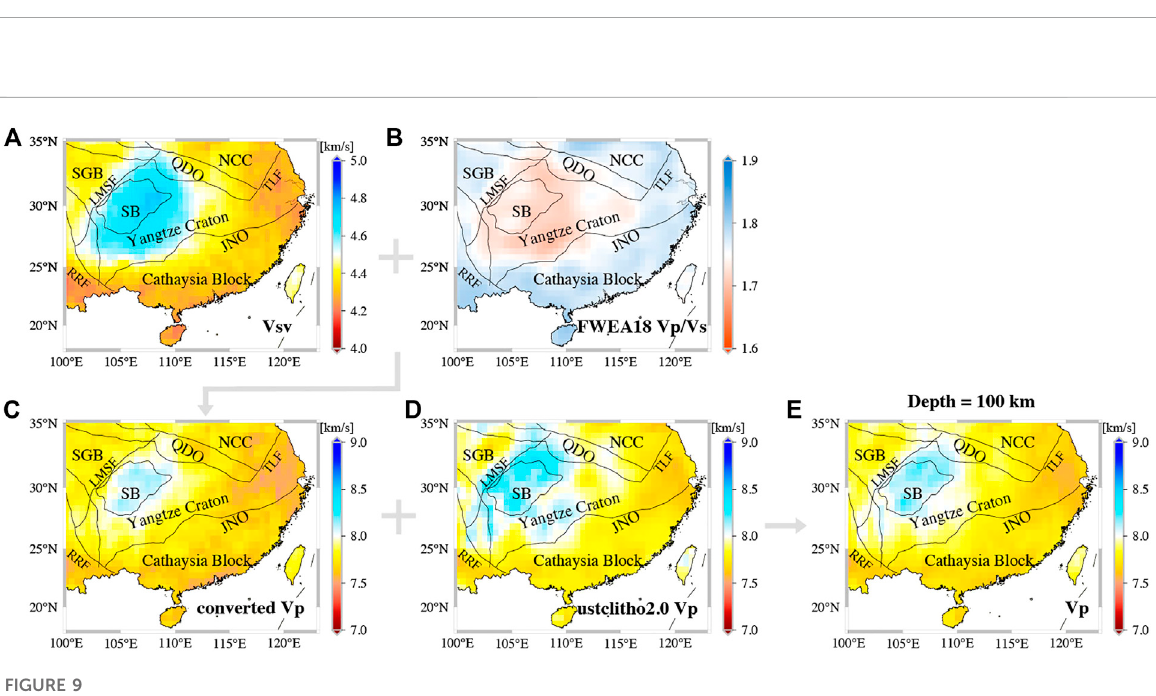
Frontiers in Earth